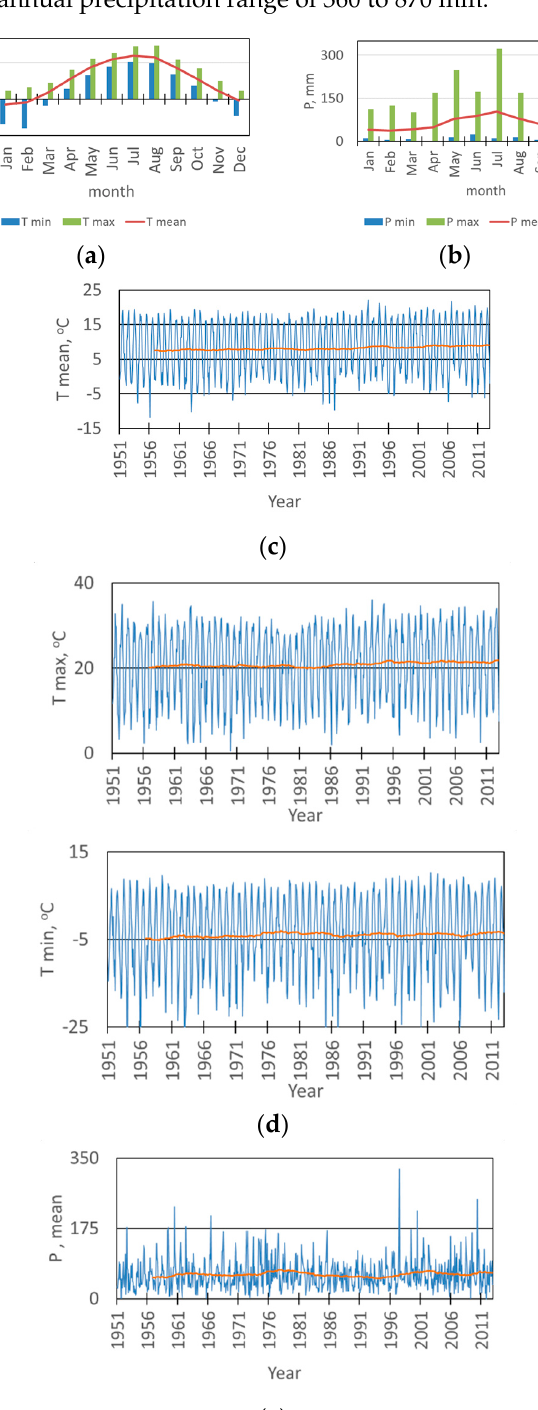
Figure 1. Trends and intraannual variation in air temperature (T) and amount of precipitation (P) mean value (mean) and extremes (max-maximum, min-minimum) ( a , b ) and comparison of time series, and trends in the total amount of precipitation and mean, maximum (max) and minimal (min) air temperature, respectively, orange lines indicate a trend of 5-year mean of average temperature ( c ), maximal and minimal temperature ( d ) and the sum of precipitation ( e ), in the investigated area